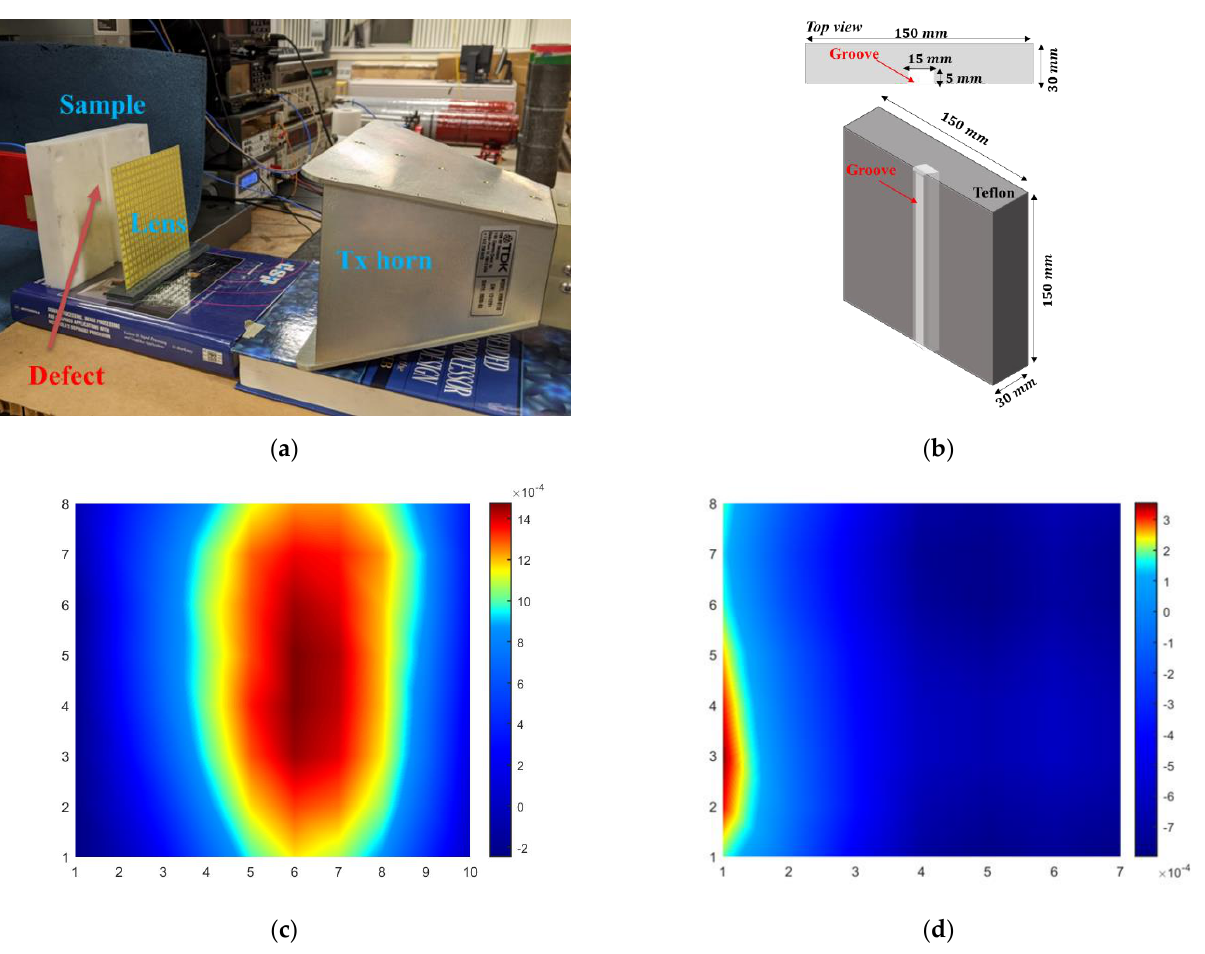
Figure 11. ( a ) Microwave NDE experiment setup. ( b ) Schematic of Teflon sample under test with machined groove. ( c ) Microwave imaging results of groove defect with lens and ( d ) without lens.